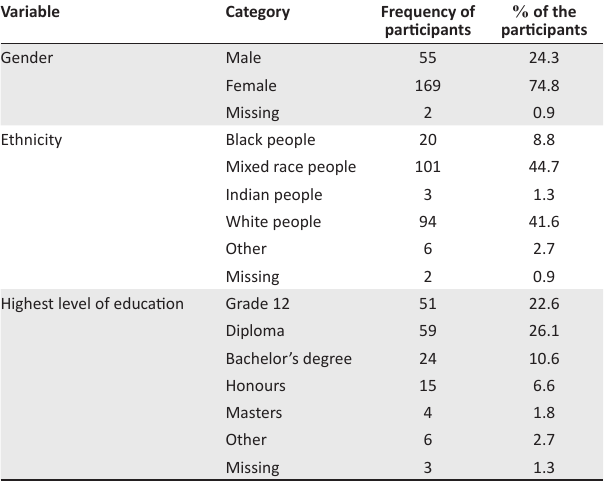
TABLE 1: Demographic characteristics of